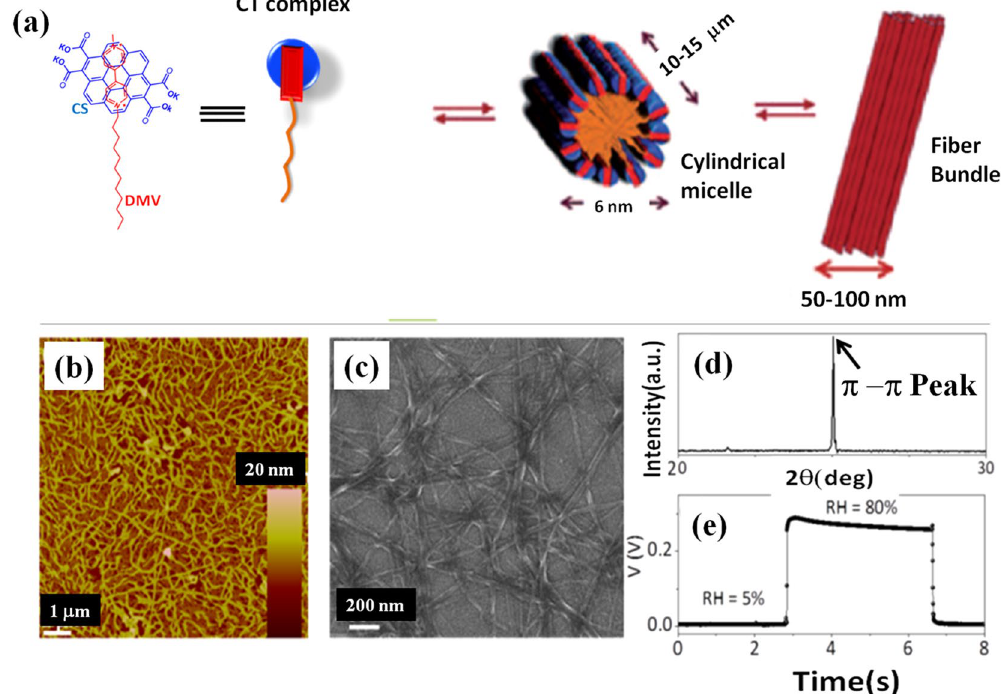
Figure 1. ( a ) Schematics of the self organization mechanism of DMV-CS nanofibers, initially single columnar micelle are formed and then these micelles aggregate further to form 50–150 nm diameter nanofibers. The molecular structure of DMV and CS molecules are also shown. ( b ) Tapping mode AFM image of DMV-CS nanofiber film dried after spin coating on a substrate. ( c ) FESEM image of nanofiber film after drying exhibit 1D nature of nanofibers. ( d ) X-ray diffraction data of the dried film measured at ambient conditions (26 °C, 40% RH). The peak at 2 θ = 25.03° corresponds to π - π distance (3.555 Å) between DMV and CS charge transfer